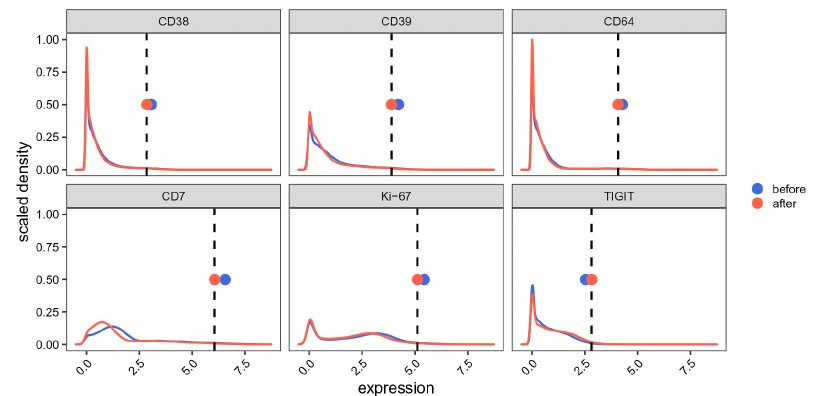
Figure 17. Batch alignment quality control. Expression distributions before (blue) and after (red) quantile scaling using 7 previously acquired experiments as reference. Included are the 6 most affected channels (i.e., highest absolute correction factors). Dashed lines indicate 98th expression percentiles averaged across references; points represent the respective distributions’ 98th